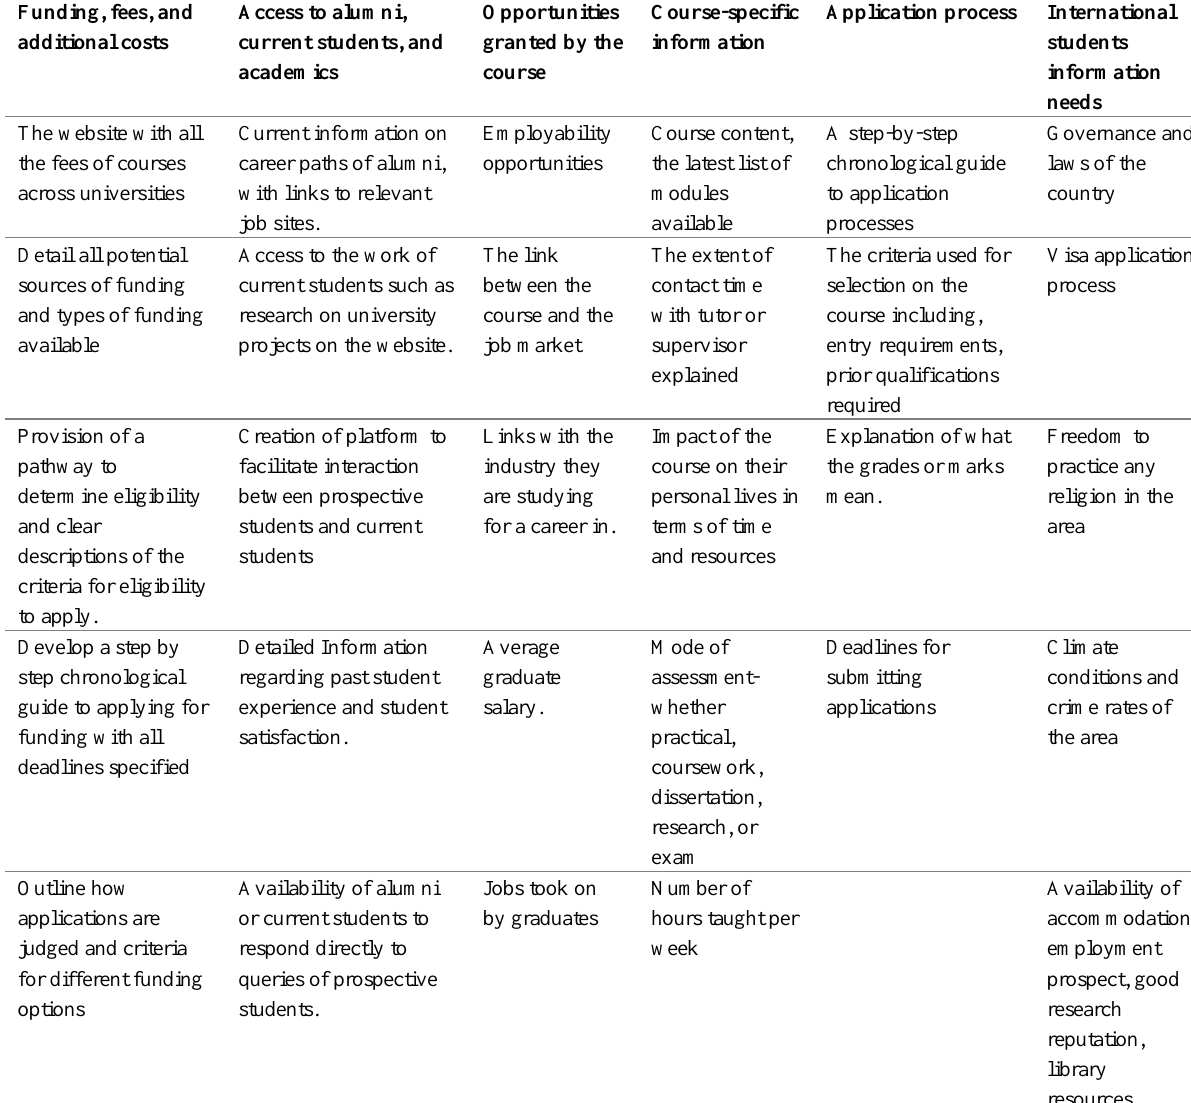
Table 1: Information needs of prospective postgraduate